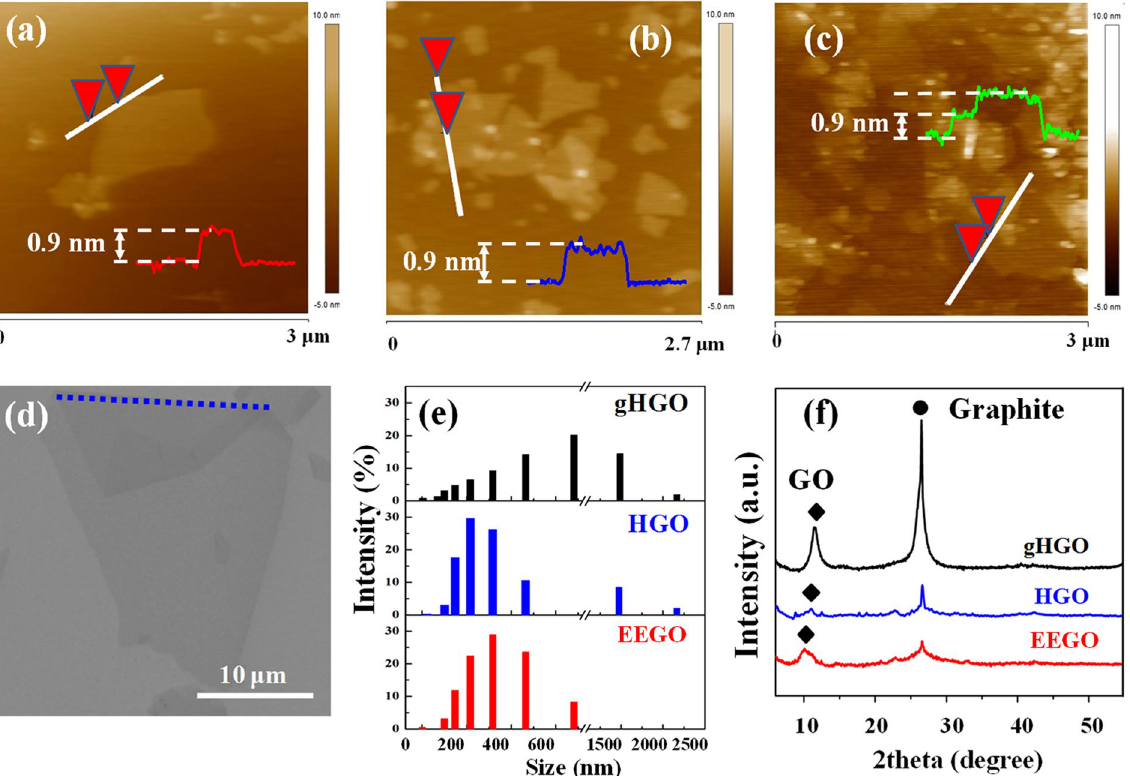
Figure 4. The AFM results of EEGO ( a ), HGO ( b ), and gHGO ( c ) products. The SEM images of an EEGO sheet ( d ) with a folding lines in blue. ( e ) The hydrodynamic size distribution of the GO samples by DLS. ( f ) The XRD of the precipitates sampled from each GO by a 6000 rpm centrifuge.